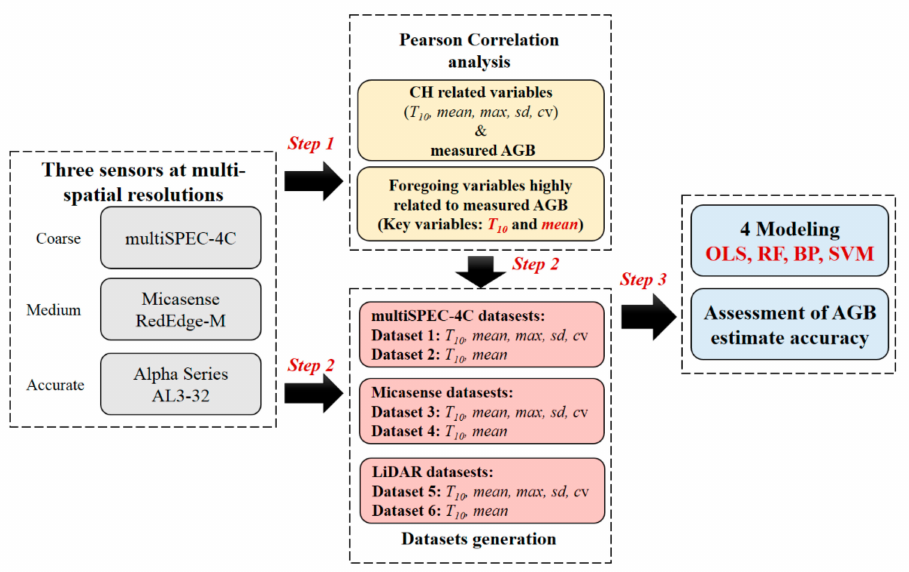
Figure 6. Flowchart of this study to estimate the above-ground biomass (AGB) of maize using UAV-based multispectral SfM and LiDAR point